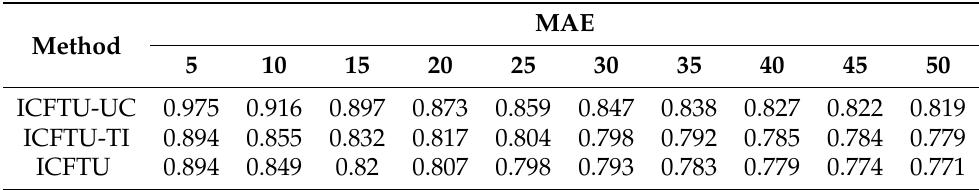
Table 3. The results of the ablation experiment of MAE.